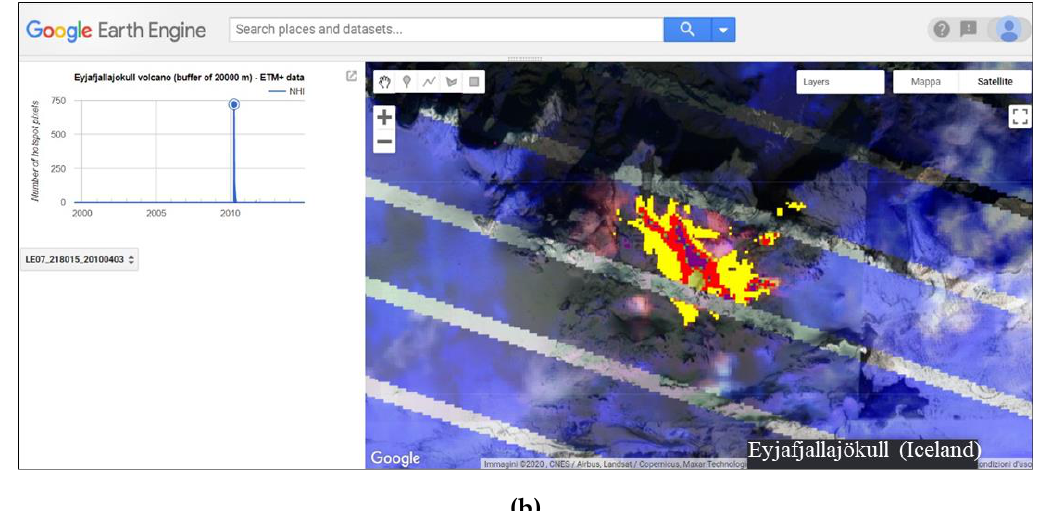
Figure 13. Preliminary implementation of the NHI algorithm on Landsat TM/ETM+ data, performed under the GEE platform; (a) Mount St. Helens ( 46°12′0.89″N 122°8′44.17″W ) activity investigated using Landsat-5 TM data of 1985 − 2010. On the right, thermal anomaly map of 14 October 2004; (b) Eyjafjallajökull (63°37 ′ 12 ″ N 19°36 ′ 48 ″ W) thermal activity of 1999 − 2014 analyzed using Landsat-7 ETM+ data. On the right, thermal anomaly map of 3 April 2010 generated using the same color code as Figure 3. In background the RGB imagery.